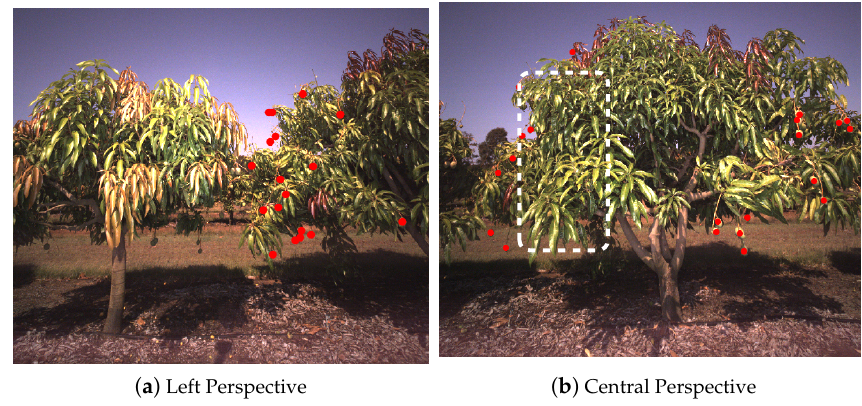
Figure 18. Fruit that was detected from the left perspective (a) of a tree is hidden from view in the central perspective (b), due to occlusion of the foliage in the foreground. Red dots denote detected fruit and the white rectangle marks the region of the tree where the hidden fruit would be.